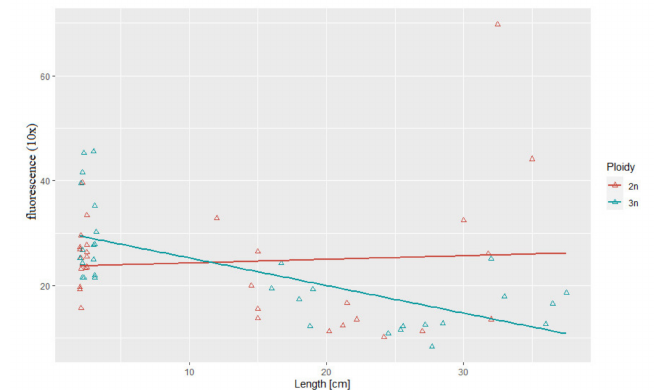
Figure 3. Relationship between telomere length-related fluorescence and body length in the examined triploid ( r 2 = 0.69, p > 0.05) and diploid ( r 2 = 0.07) rainbow trout.